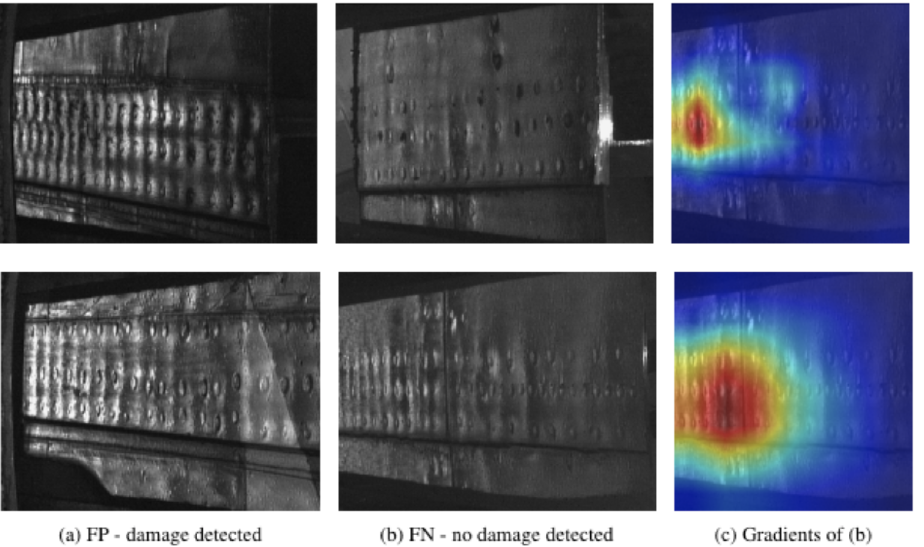
Figure 8. Examples of images that the Deep Learning architecture DenseNet-201 did not predict well. Column ( a ) corresponds to images misclassified with corrosion or false positives (FP), while column ( b ) includes images with misclassified corrosion detected or false negatives (FN). In ( c ), we use Grad-CAM for the visual interpretability of the DenseNet-201’s gradients over the image in ( b